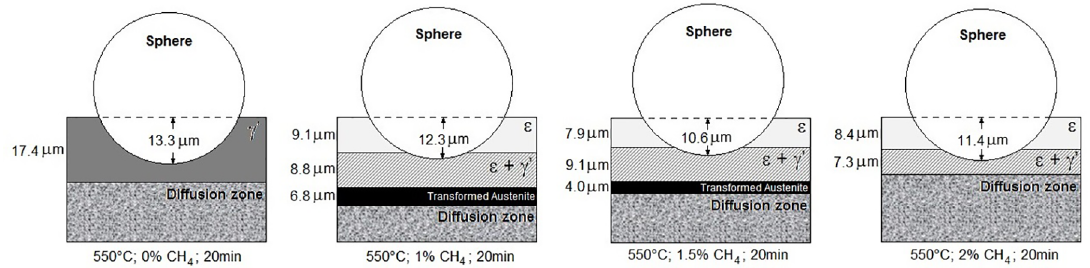
Figure 10. Schematic illustration of wear crater depth (temperature of 550°C and 20 minutes testing).